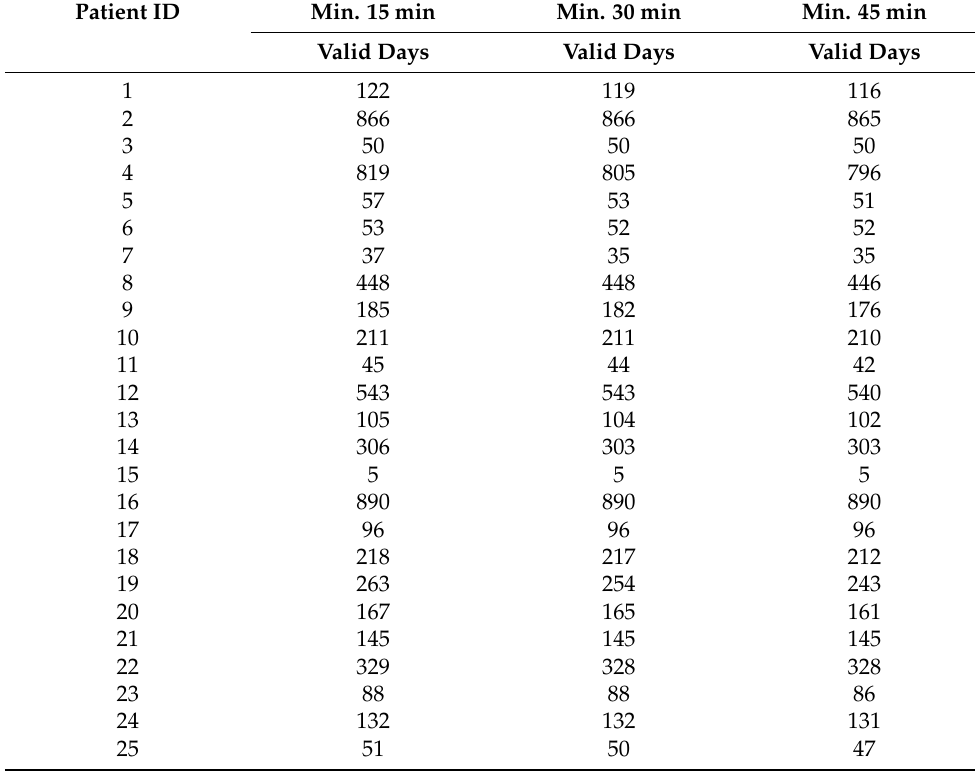
Table A4. Valid Fitbit days for day validation scenario type 2 (27